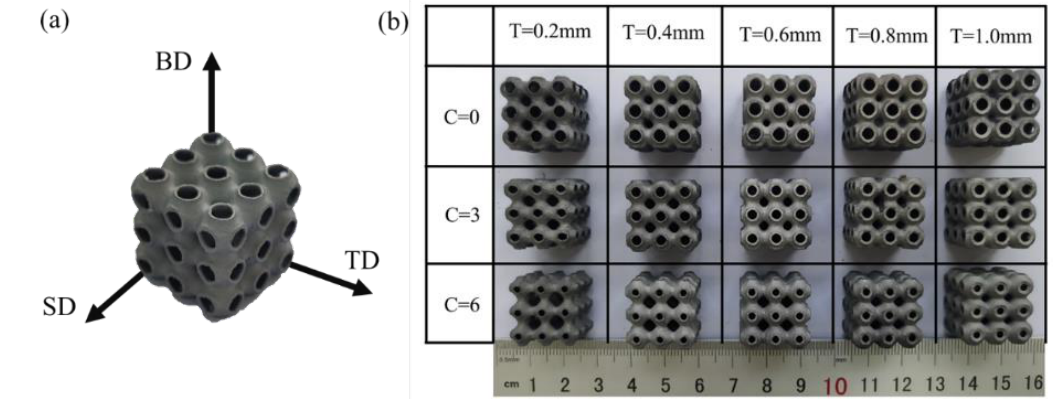
Figure 3. ( a ) Schematic diagram of the scanning strategy. BD represents building direction, SD stands for scanning direction, and TD is the transverse direction. ( b ) Top view of the P-TPMS structure with different structural parameters. Table 1. Details of the primitive structures studied in this